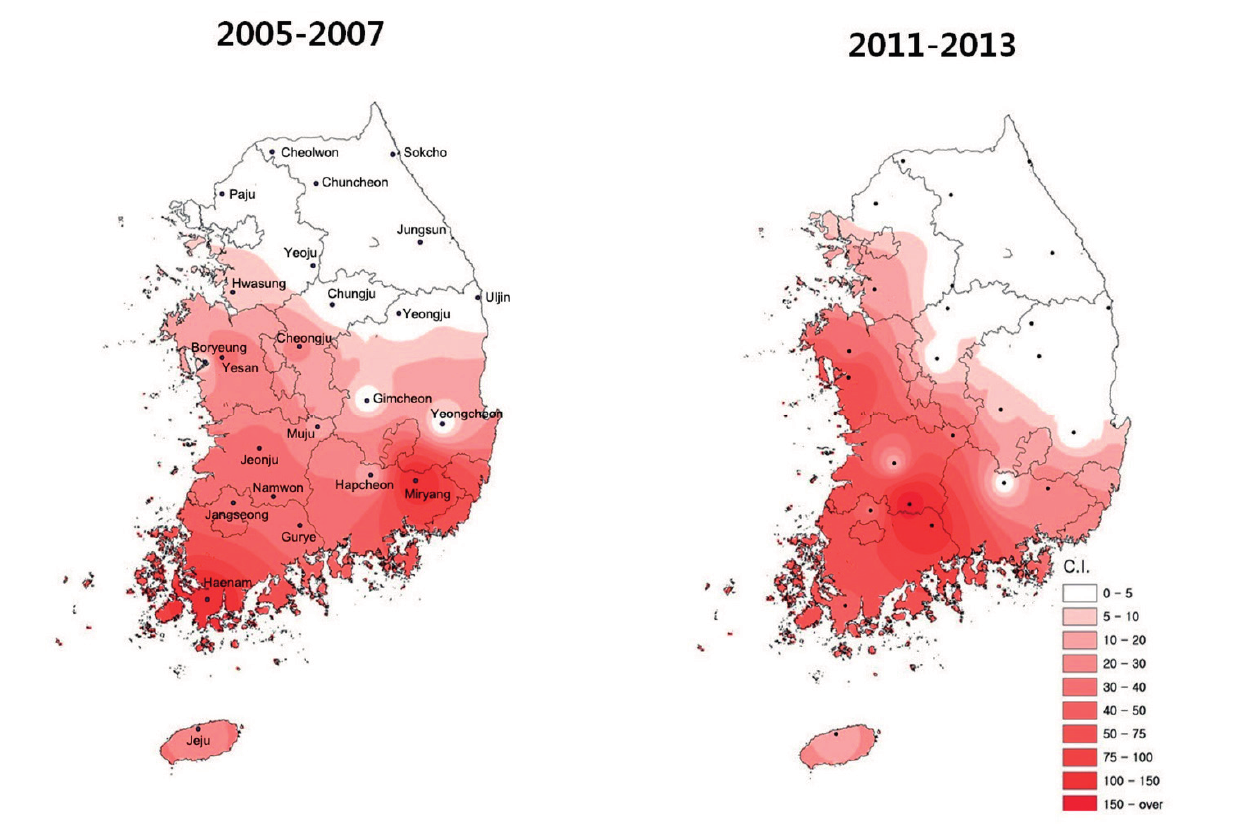
Figure 1 . Geographical distribution of Orientia tsutsugamushi vector, L. scutellare density in Korea [39]; C. I. (confidence interval) color and number indicated the collected cases of chiggers that has scrub typhus ( L. scutellare ).